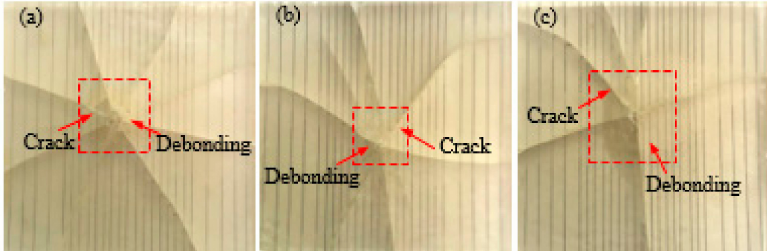
Figure 7. The failure modes diagrams of specimens with different SMA diameters under 5 J of energy: ( a – c ) indicate the SMA reinforced resin-matrix test specimens with SMA diameters of 0.3, 0.4, 0.5 mm,